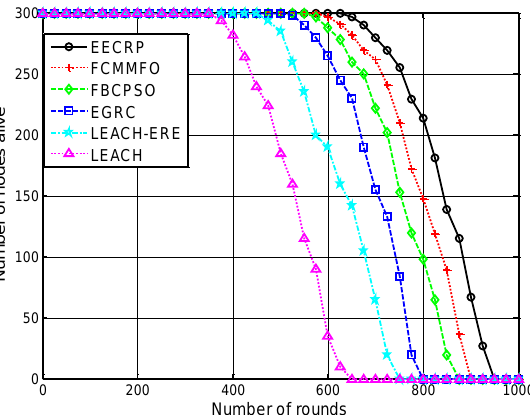
Figure 9. The number of nodes alive versus the number of rounds for different protocols.